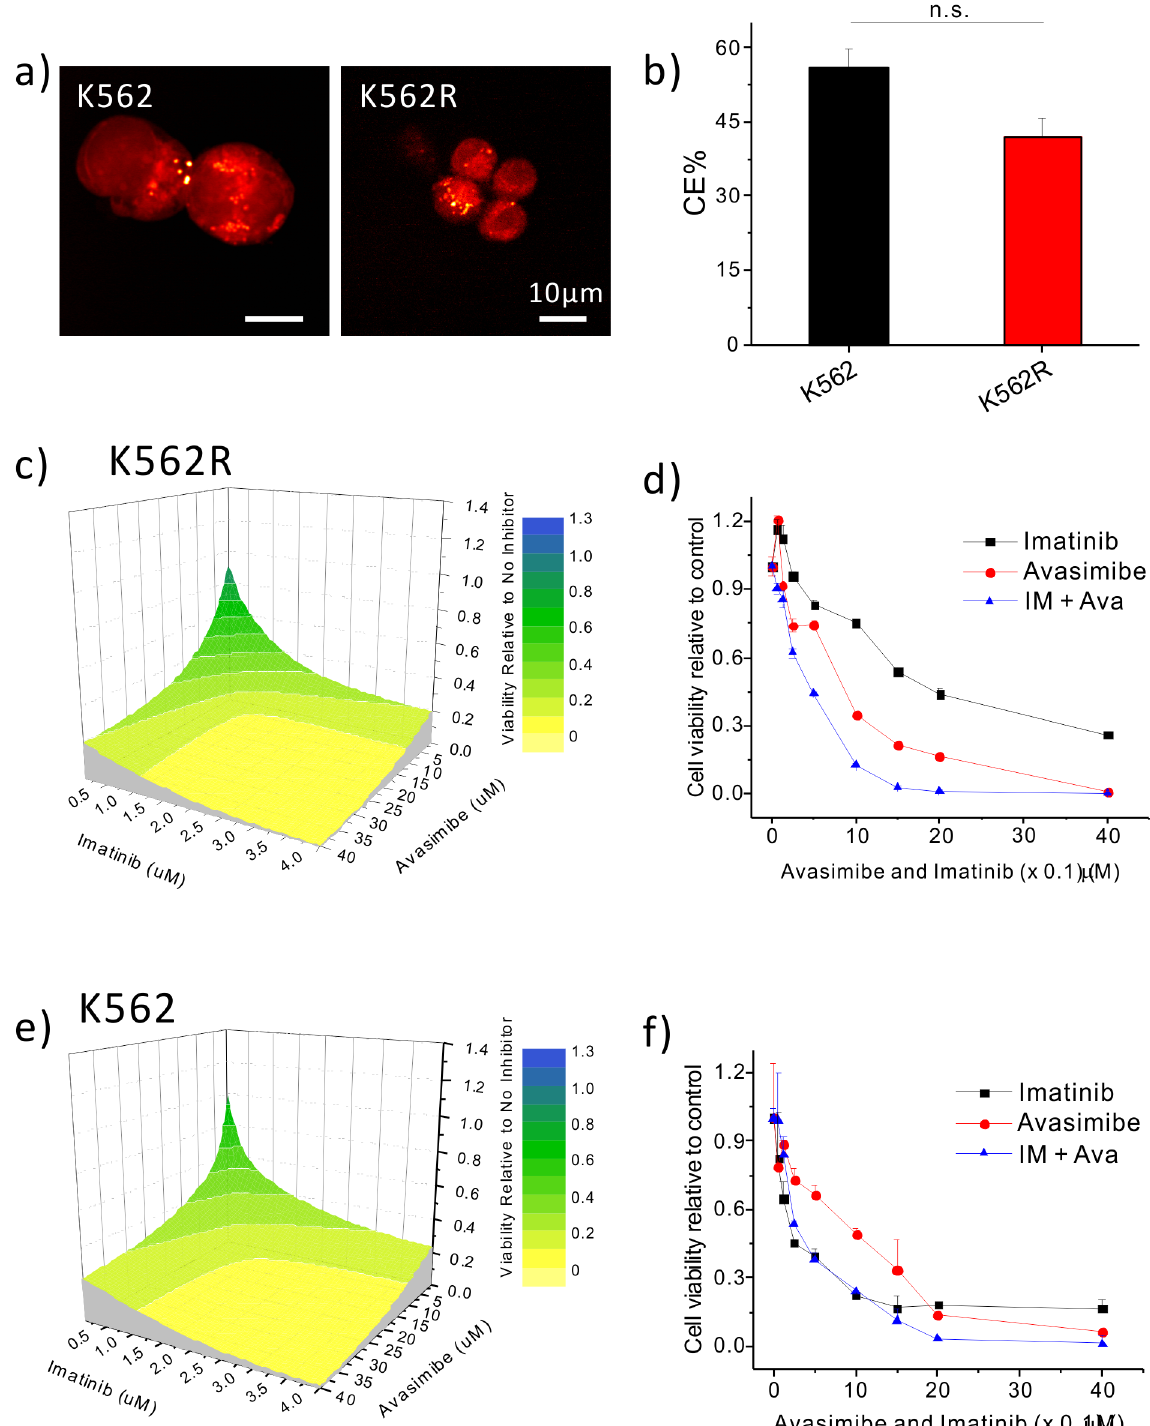
Fig 2. Imatinib and avasimibe show a significant synergy in inhibiting viability of K562R cells. (a) Representative SRS images of K562 and K562R cells. (b) Quantificationof CE% in LDs of K562 and K562Rcells. The results are shownas means + SEM, n = 6. Two-way student t test was used for statistical analysis;n.s. indicatesno significance. (c) 3D contour plot with colormap(d) linear plot of K562R cells treated with imatinib,avasimibe,or combination of imatiniband avasimibeat a molar concentration ratio of 1: 10 (IM: Ava) for 72 hours. (e) 3D contour plot with colormap(f) linear plot of K562 cells treated with imatinib,